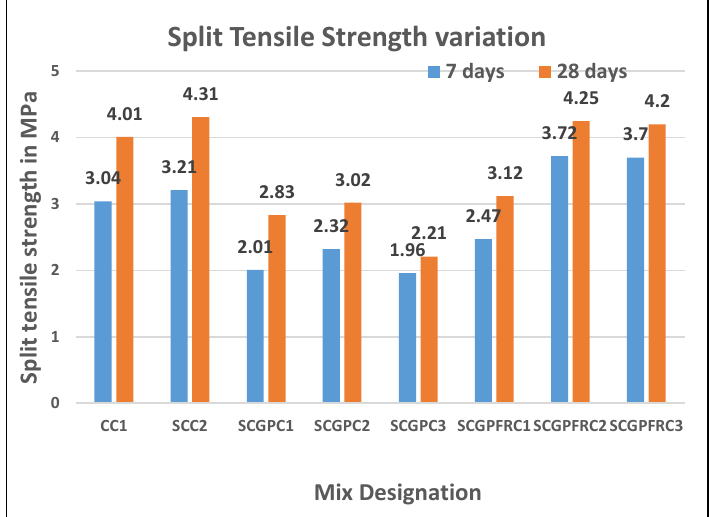
Fig. 13. Graph showing the variation of Split tensile strength for all